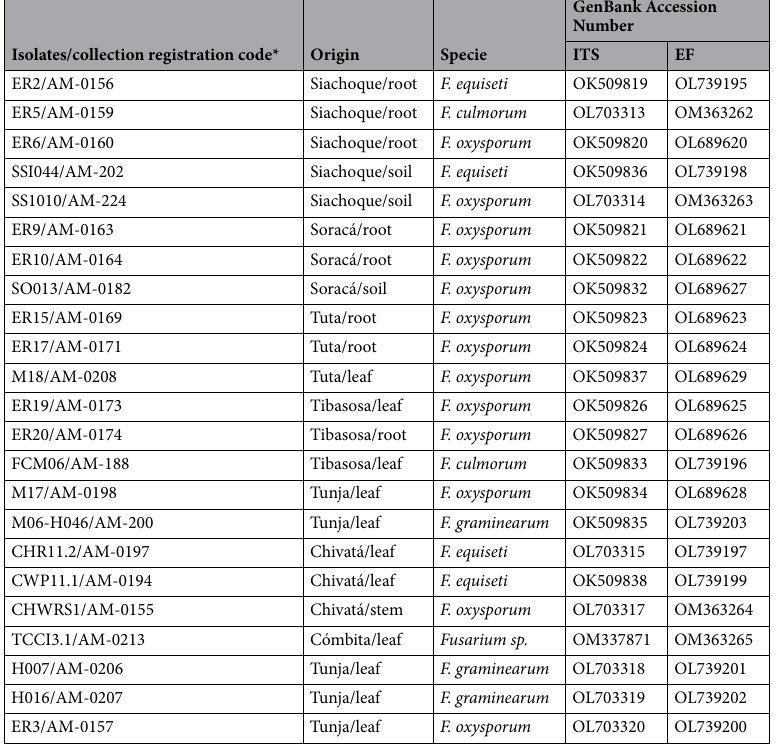
Table 2. List of Fusarium complex isolates sequenced in the present study and their GenBank information together with their relatives to build a phylogenetic tree. The asterisks indicate the registration code of the isolates in the “Colección de Hongos y Microorganismos de la Universidad de Boyacá ’’, UBCHM. The markers used did not allow the identification of the species level of the isolate TCCI